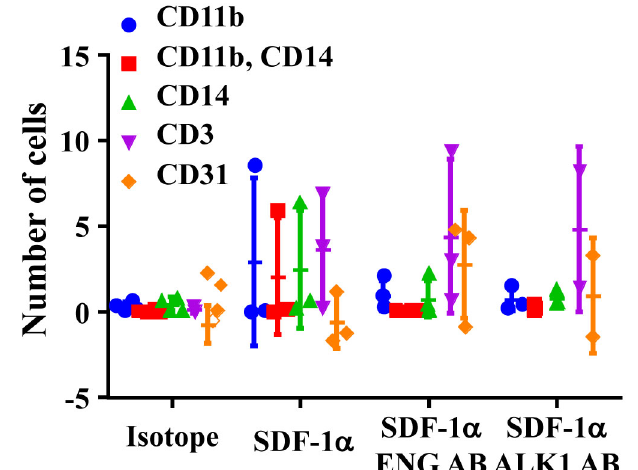
Figure 3. ENG antibody (ENG AB) or ALK1 antibody (ALK1 AB) pre-treatment reduced monocyte-migration toward SDF-1α. Isotope: MNCs pretreated with corresponding IgGs for ENG AB and ALK1 AB. SDF-1α: SDF-1α was added to bottom chamber in migration assay; SDF-1α ENG AB or SDF-1α ALK1 AB: MNCs pre-treated with ENG or ALK1 antibody and with SDF-1α in the bottom chamber